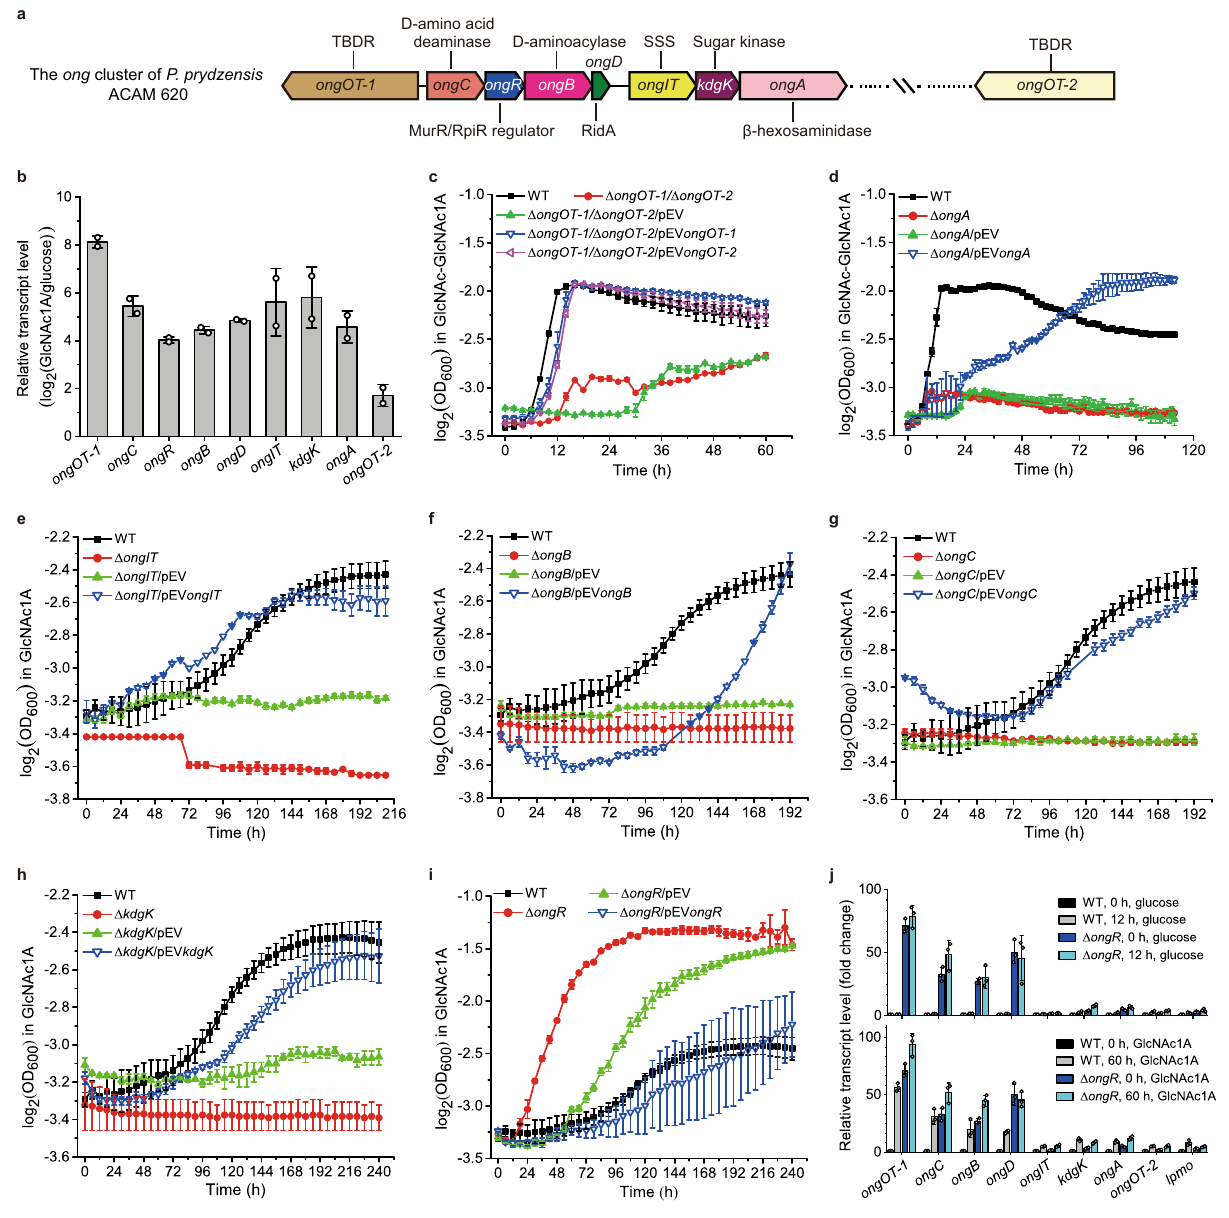
Fig. 3 | Identi fi cation of key genes in strain ACAM 620 involved in utilizing oxidized chitooligosaccharides basedontranscriptomic and geneticanalyses. a Genetic organization of the ong cluster of strain ACAM 620. TBDR, TonB- dependent receptor; SSS, sodium solute symporter. b RNA-seq assay of the tran- scriptions of genes from the ong cluster and ongOT-2 in strain ACAM 620 in the minimalmediumsupplementedwith0.2%(w/v)GlcNAc1A.Valuesareexpressedas fold change (log 2 ) compared to cultures in the minimal medium supplemented with 0.2% (w/v) glucose. Data are presented as mean±SD ( n =2 independent experiments). c – i The growth phenotype of strain ACAM 620 with a single gene deletion in the ong cluster on GlcNAc1A or GlcNAc-GlcNAc1A as the sole carbon source.Wild-typestrain(WT),mutantstrainsandcomplementedstrainsofmutants